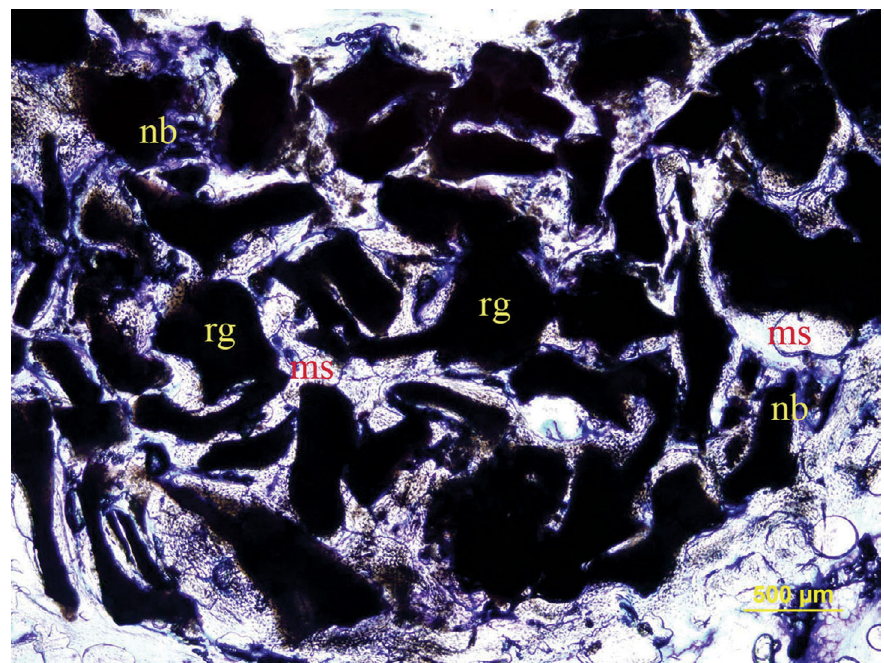
Figure 4- Histological transversal section stained with toludine blue in xenograft group (original magnification 4×). nb: new bone; ms: marrow space; rg: residual graft